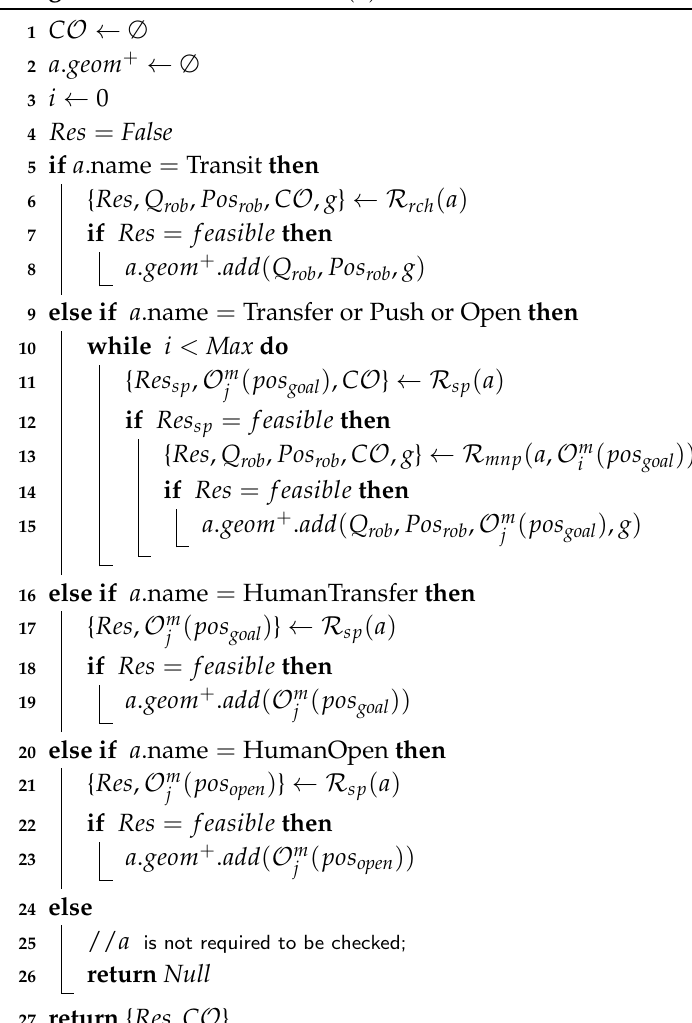
Algorithm 1: RelaxGeomReas ( a